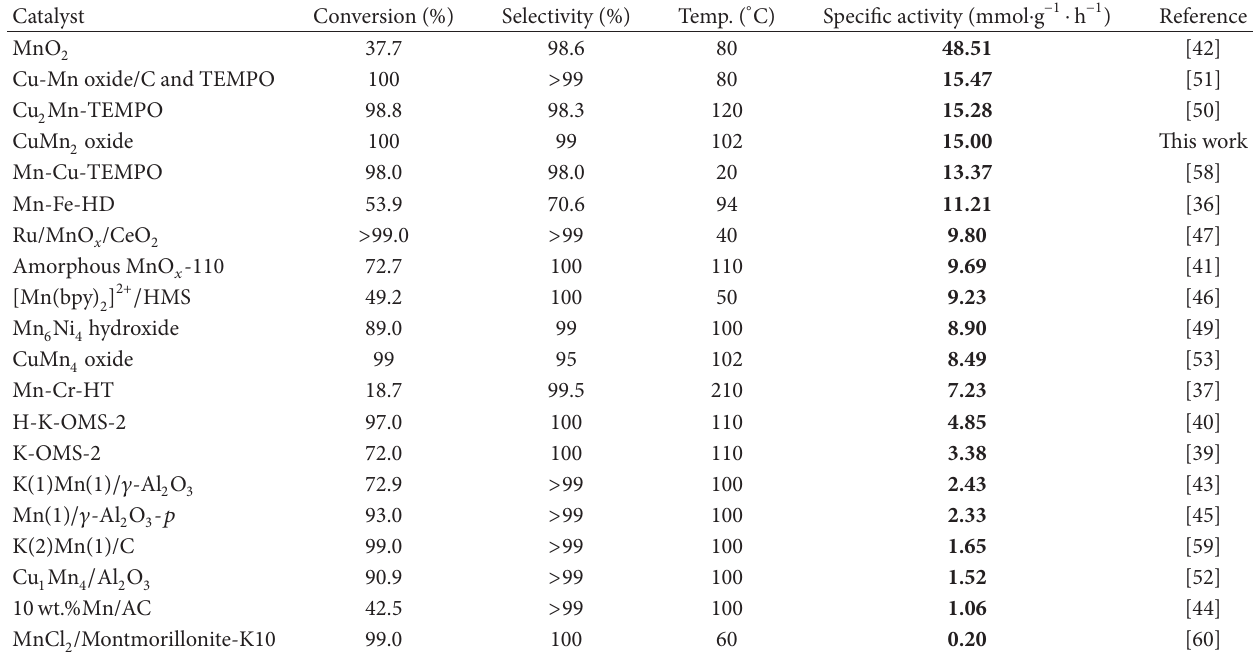
T 2: Comparison of Mn-based catalyst with earlier reported results for its catalytic performance in oxidation of benzyl alcohol to